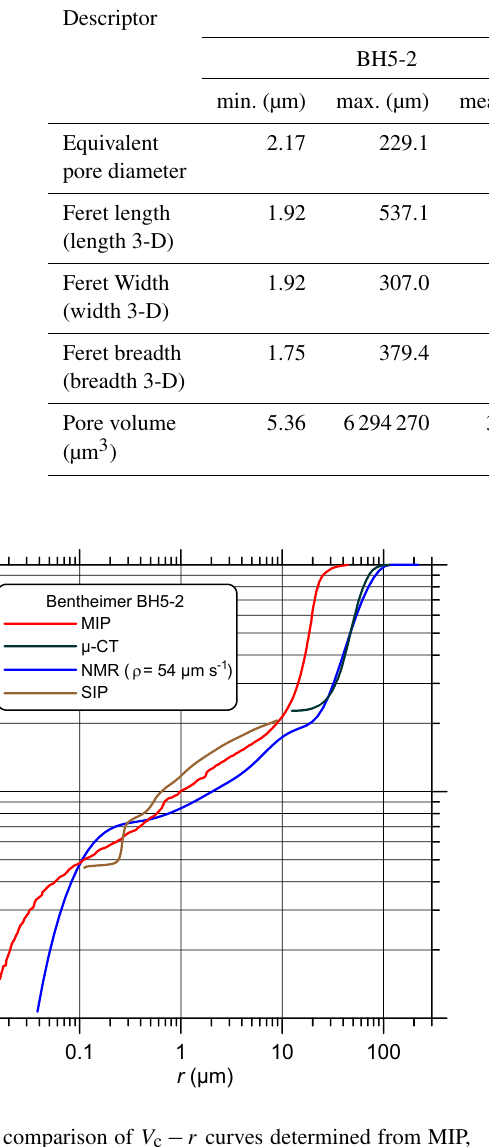
Figure 5. The comparison of V c − r curves determined from MIP, µ -CT, NMR, and SIP for Bentheimer sandstone sample BH5-2.